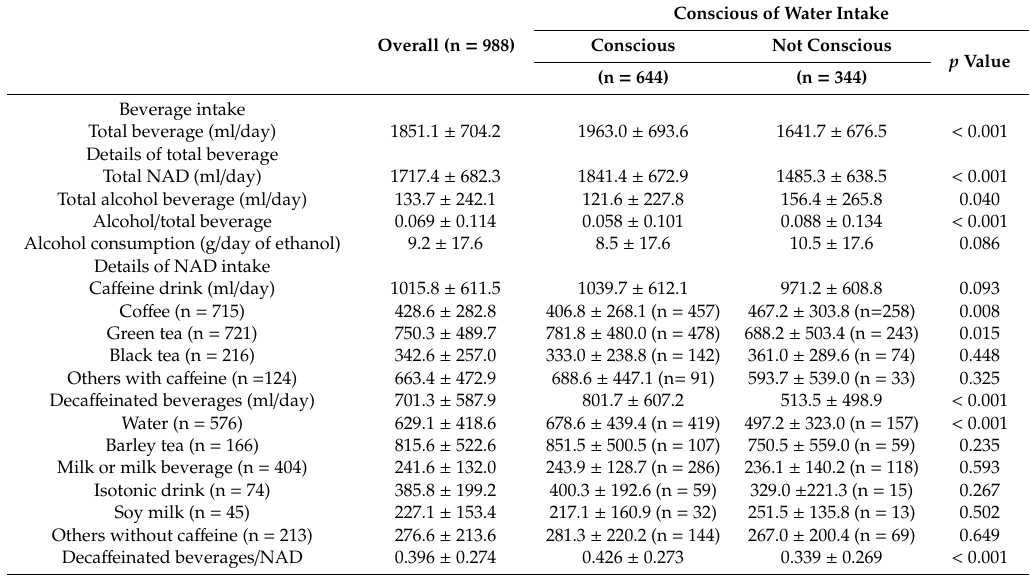
Table 3. The amount of beverage intake and its details, according to consciousness of water